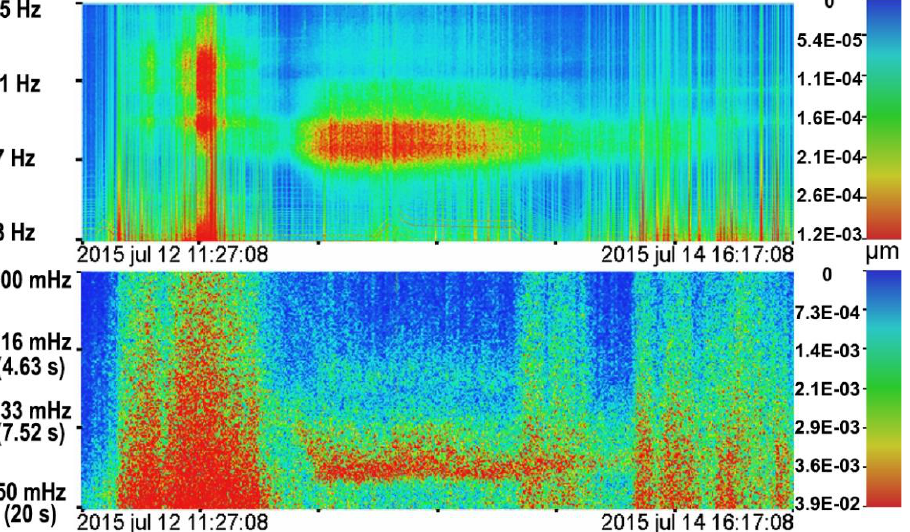
Figure 10. Dynamic spectrograms of laser strainmeter data during influence of Chan-hom typhoon.